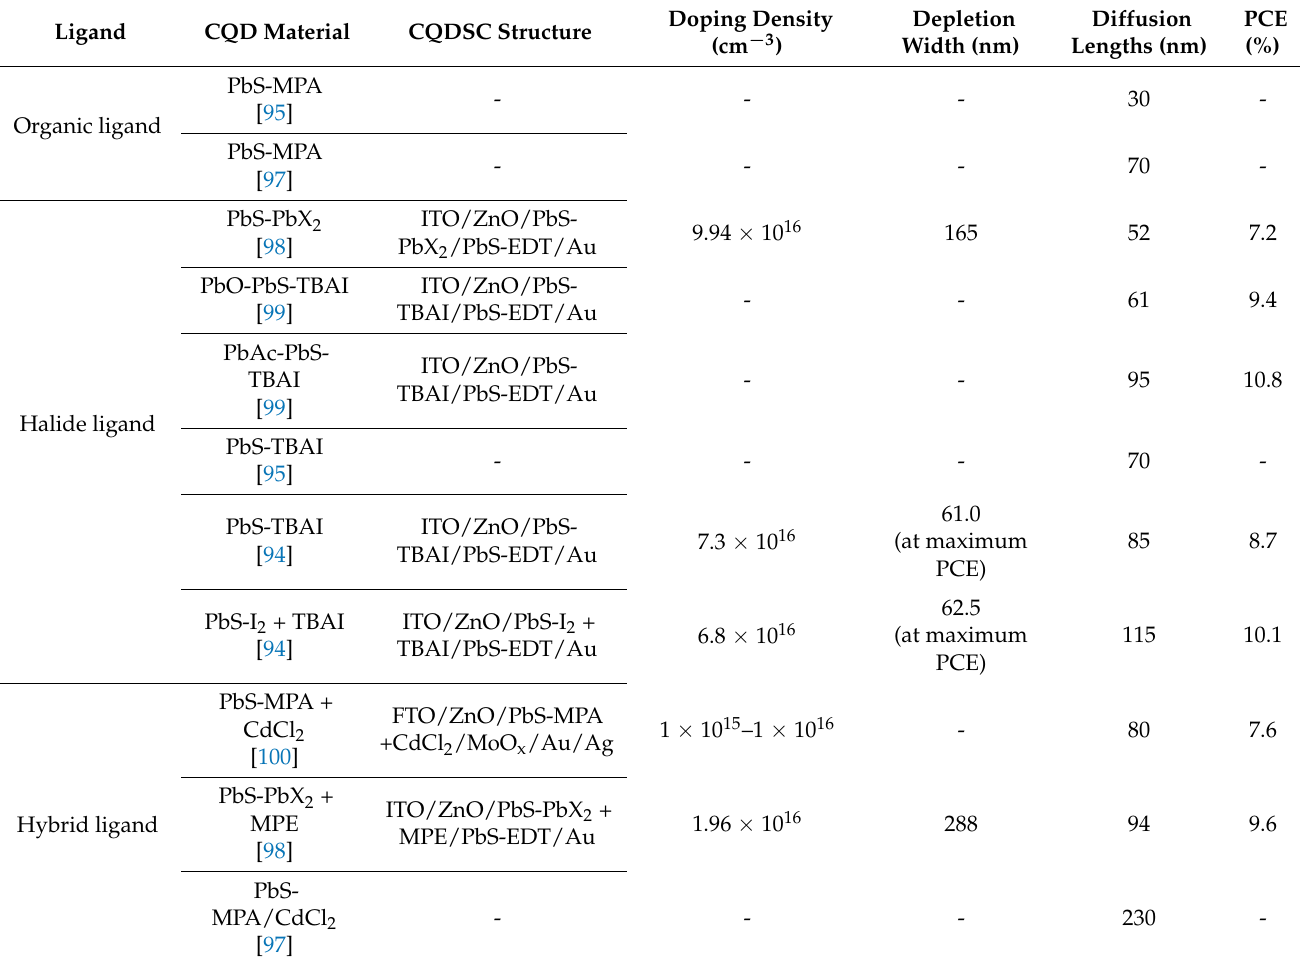
Table 3. Characteristic parameters of several lead chalcogenide QD material